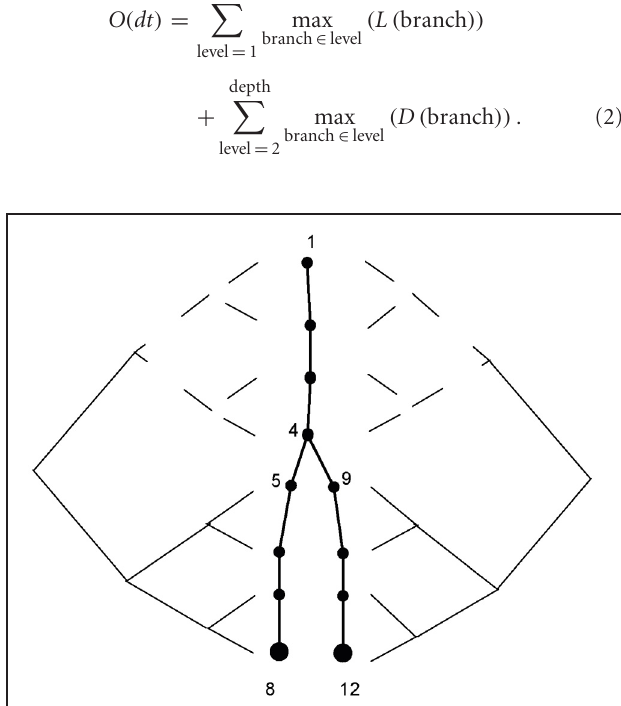
FIGURE 1 | Segment-based parallelism. The calculation for node 8 involves only segments 1–8, and is carried out in parallel according to Stone’s algorithm. The calculation for node 12 involves segments 1 , 2 , 3 , 4 , 9 , 10 , 11 , 12 and is of the same nature as the calculation for node 8, but with different indexing. Calculations for segments 1–4, which are marked by the dashed line, are the same on both sides and are carried out only